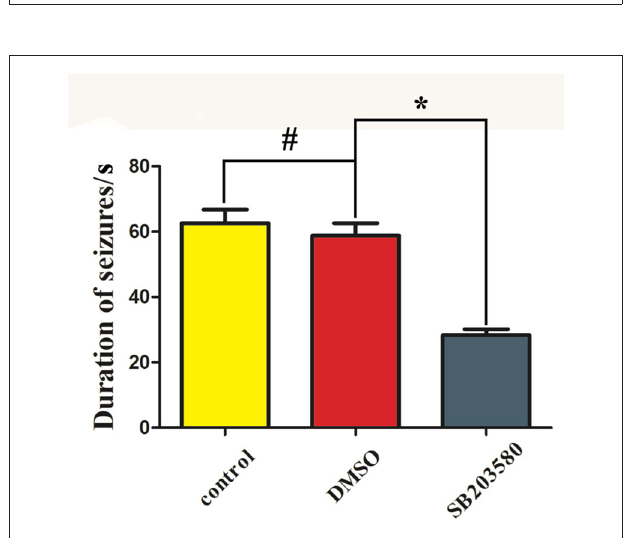
FIGURE 2 | Duration of the first seizure episode in the different groups. * P < 0.05 compared with the SB203580 group; # P > 0.05, compared with the control (epilepsy)